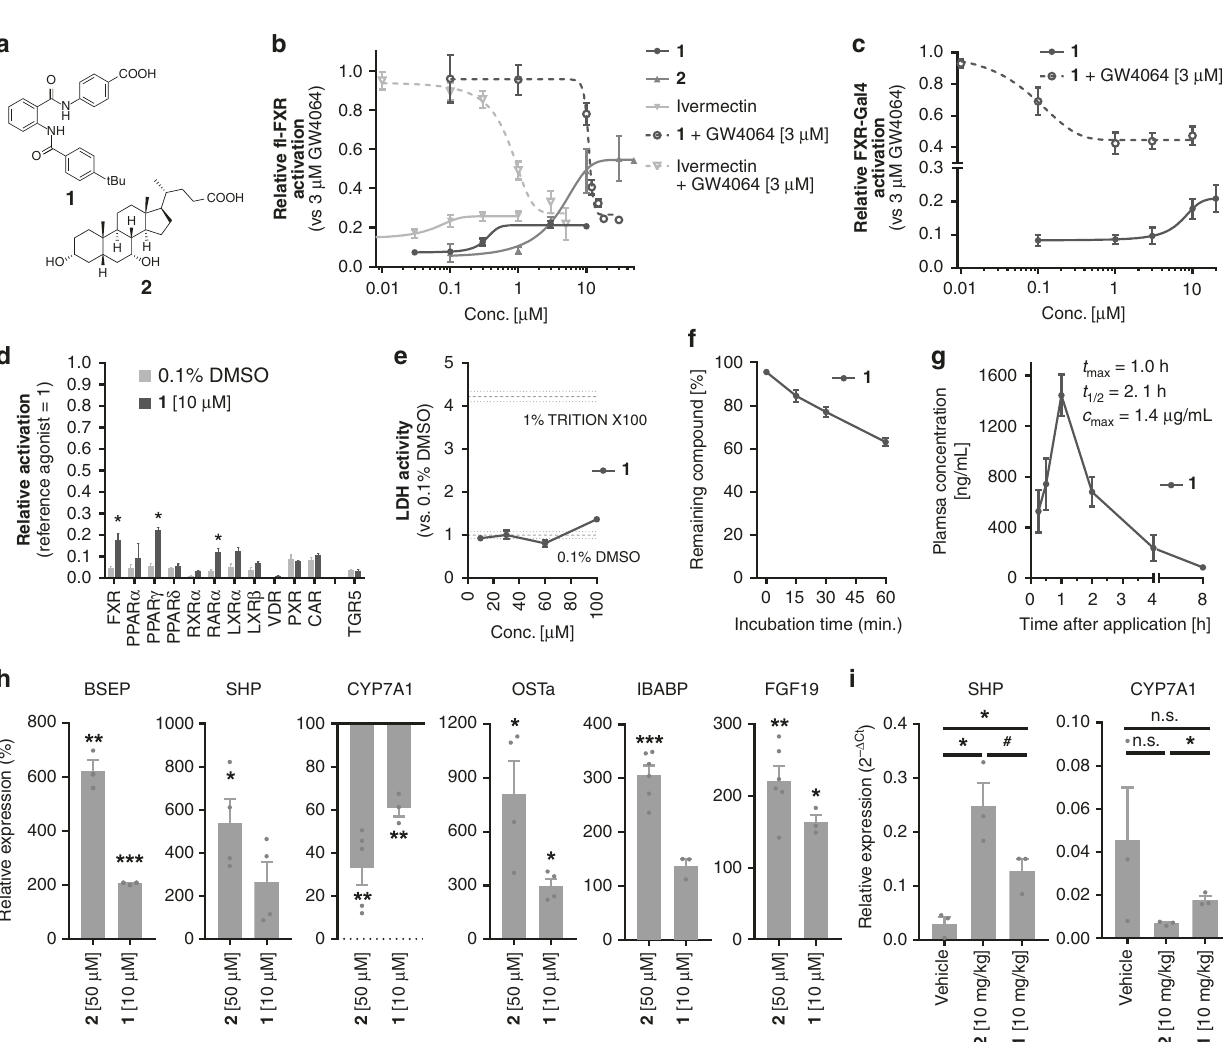
(BSEP, SHP, CYP7A1, OST α ) and in HT-29 cells (IBABP, FGF19). Results are mean ± SEM, n = 3. i Hepatic mRNA levels of FXR-regulated genes